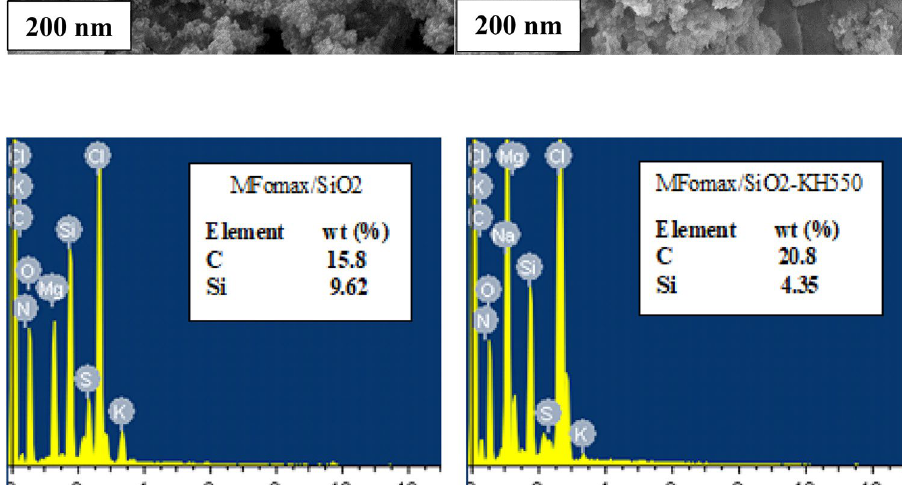
showing the elemental composi- tion in the